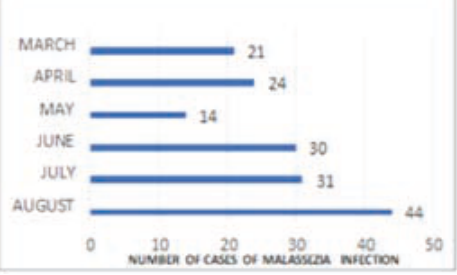
Fig. 7. Clinical cases of malassezia dermatitis among different